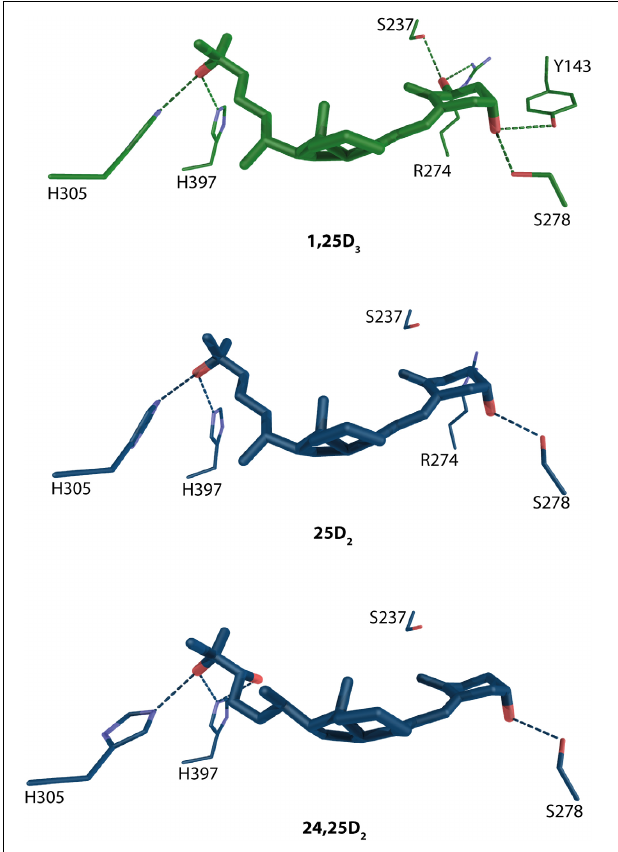
FIGURE 5 | Binding mode of 1 α , 25-dihydroxyvitamin D 3 , 25-hydroxyvitamin D 3 and its metabolite 24R,25-hydroxyvitamin D 3 in the LBP of human VDR (source MD simulation Lou et al., 2010). 1,25D 3 and 25D 3 /24,25D 3 and are highlighted in green and blue color, respectively. The hydrogen bonds are in green and blue dashed